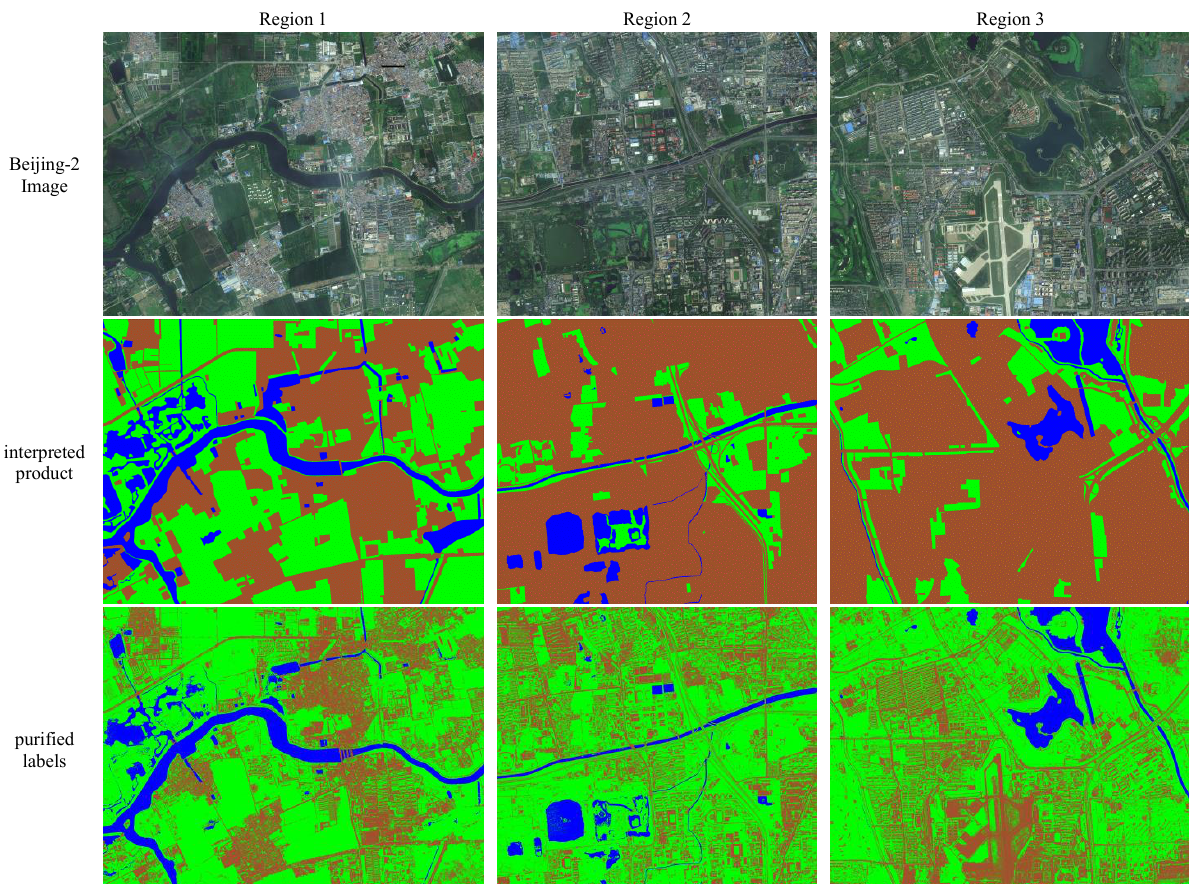
Figure 4. Test regions and the corresponding interpreted product and purified labels